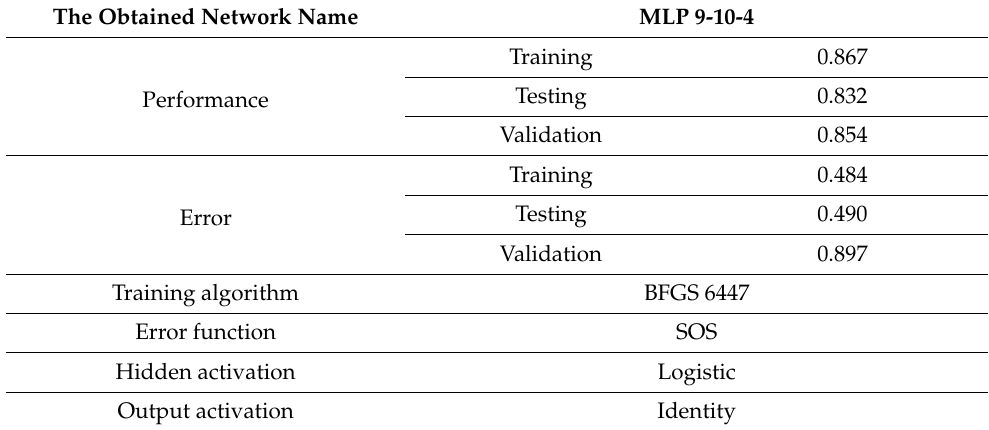
Table 3. ANN summary or observed results.